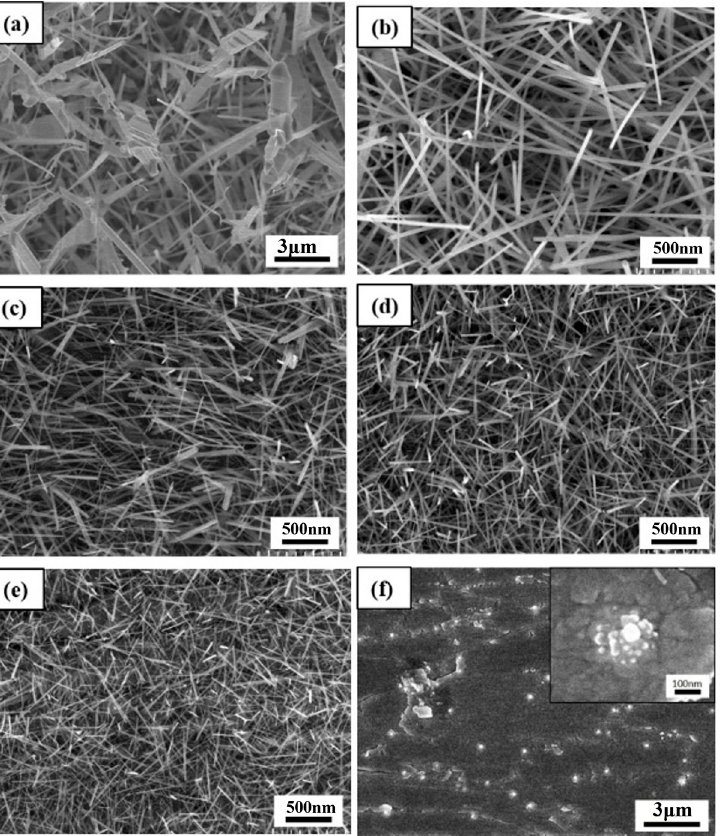
Figure 3. SEM images of NWs grown at ( a ) 850 °C ( b ) 750 °C ( c ) 700 °C ( d ) 650 °C ( e ) 600 °C ( f ) 550 °C at 0.1 torr with 5 sccm Ar for 1.5 h.